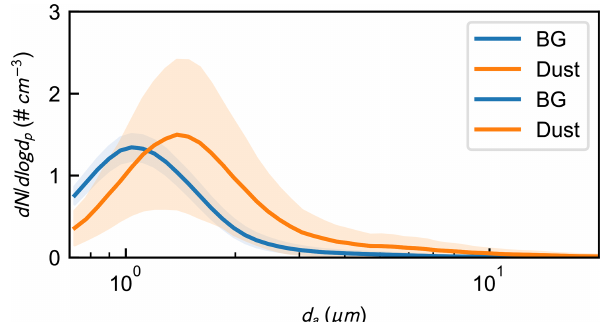
Figure A1. Aerodynamic diameter ( d a ) size distribution of particles before (00:00–06:00, 21 February; “BG”) and during the dust event (11:00–18:00, 21 February; “Dust”).